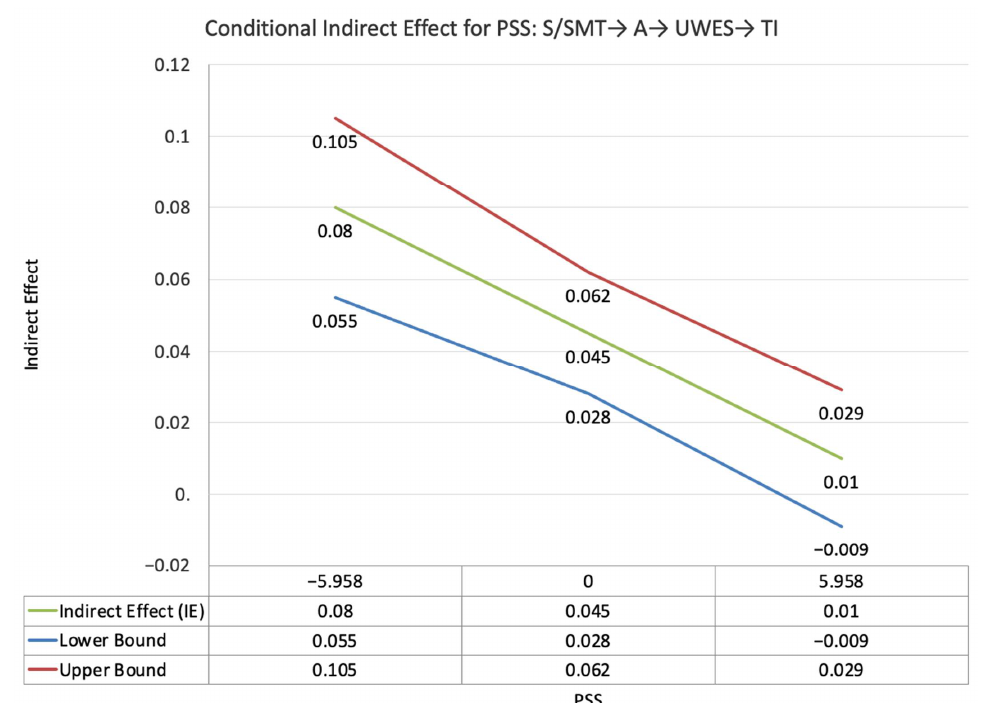
Figure 7. Conditional indirect effects of the difference between self-PMIEs compared to the control group on turnover intentions at low, average and high levels of perceived supervisor support, through autonomy satisfaction and work engagement.